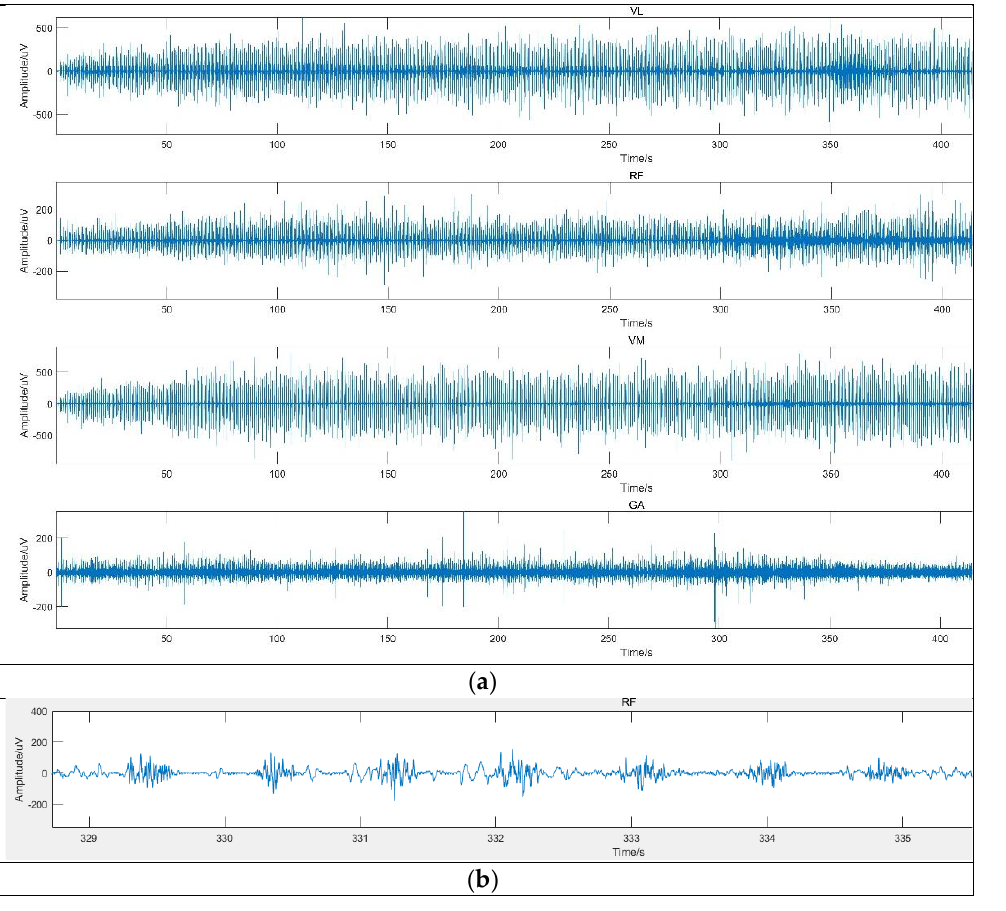
Figure 8. ( a ) The sEMG signals of VL, RF, VM, and GA denoised by improved wavelet packet threshold function; ( b ) sEMG signal of RF after local amplification.